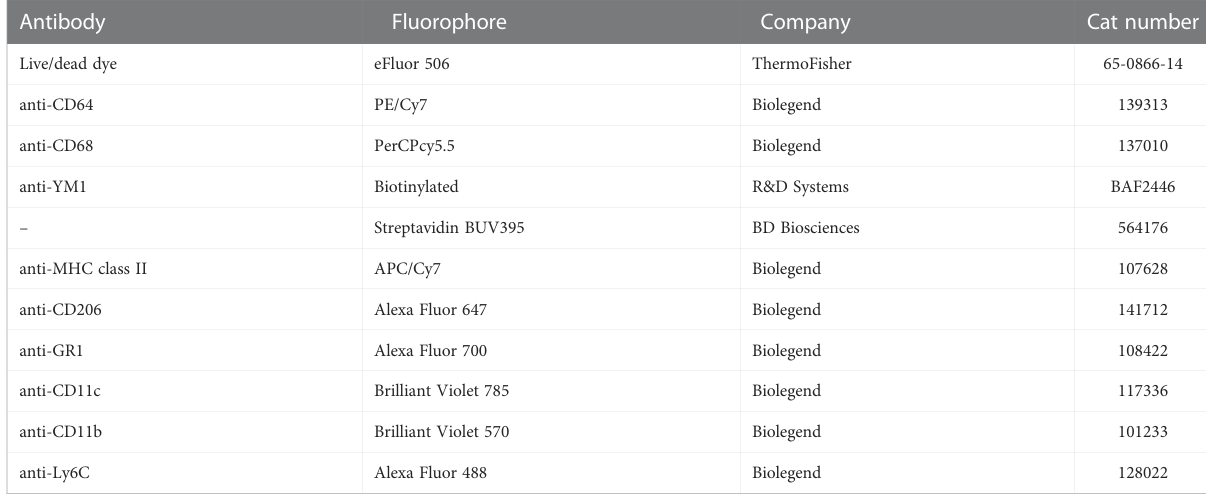
TABLE 1 Information of antibodies used to stain lung or blood